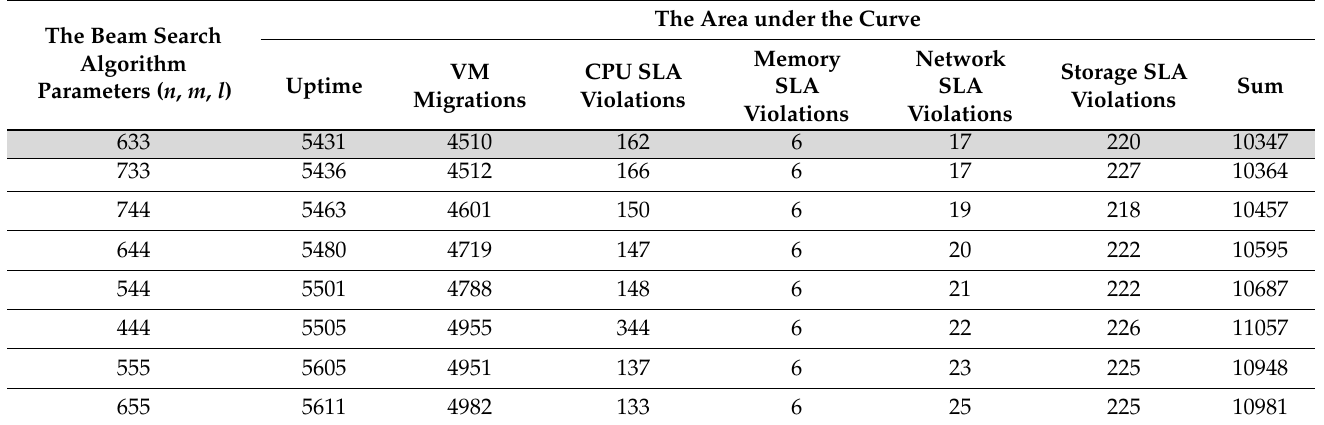
Table 3. The area under each curve approximates a specific chart in Figure 3.